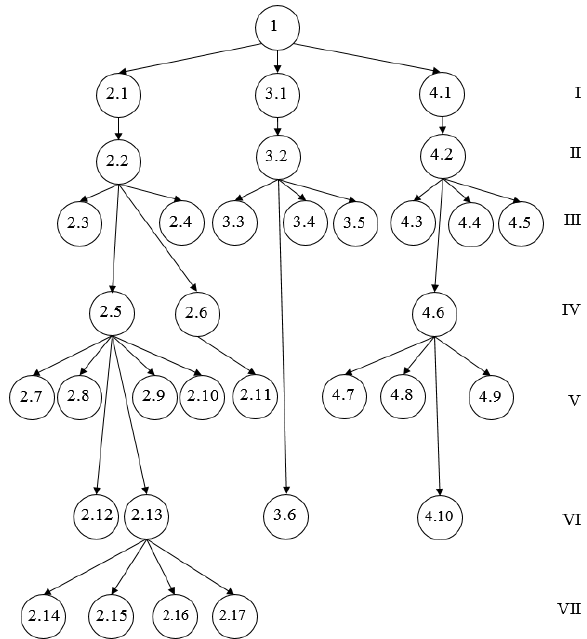
Figure 3. The objectives tree and the study tasks Since the output levels of vibration diagnosis characteristics are influenced mostly by the controlling actions associated with the structural changes in the EM parameters, we set the objectives for the development of methods and means to reduce vibration (2.5, Fig. 3) to the given vibration class (objective 2.2) at the fourth